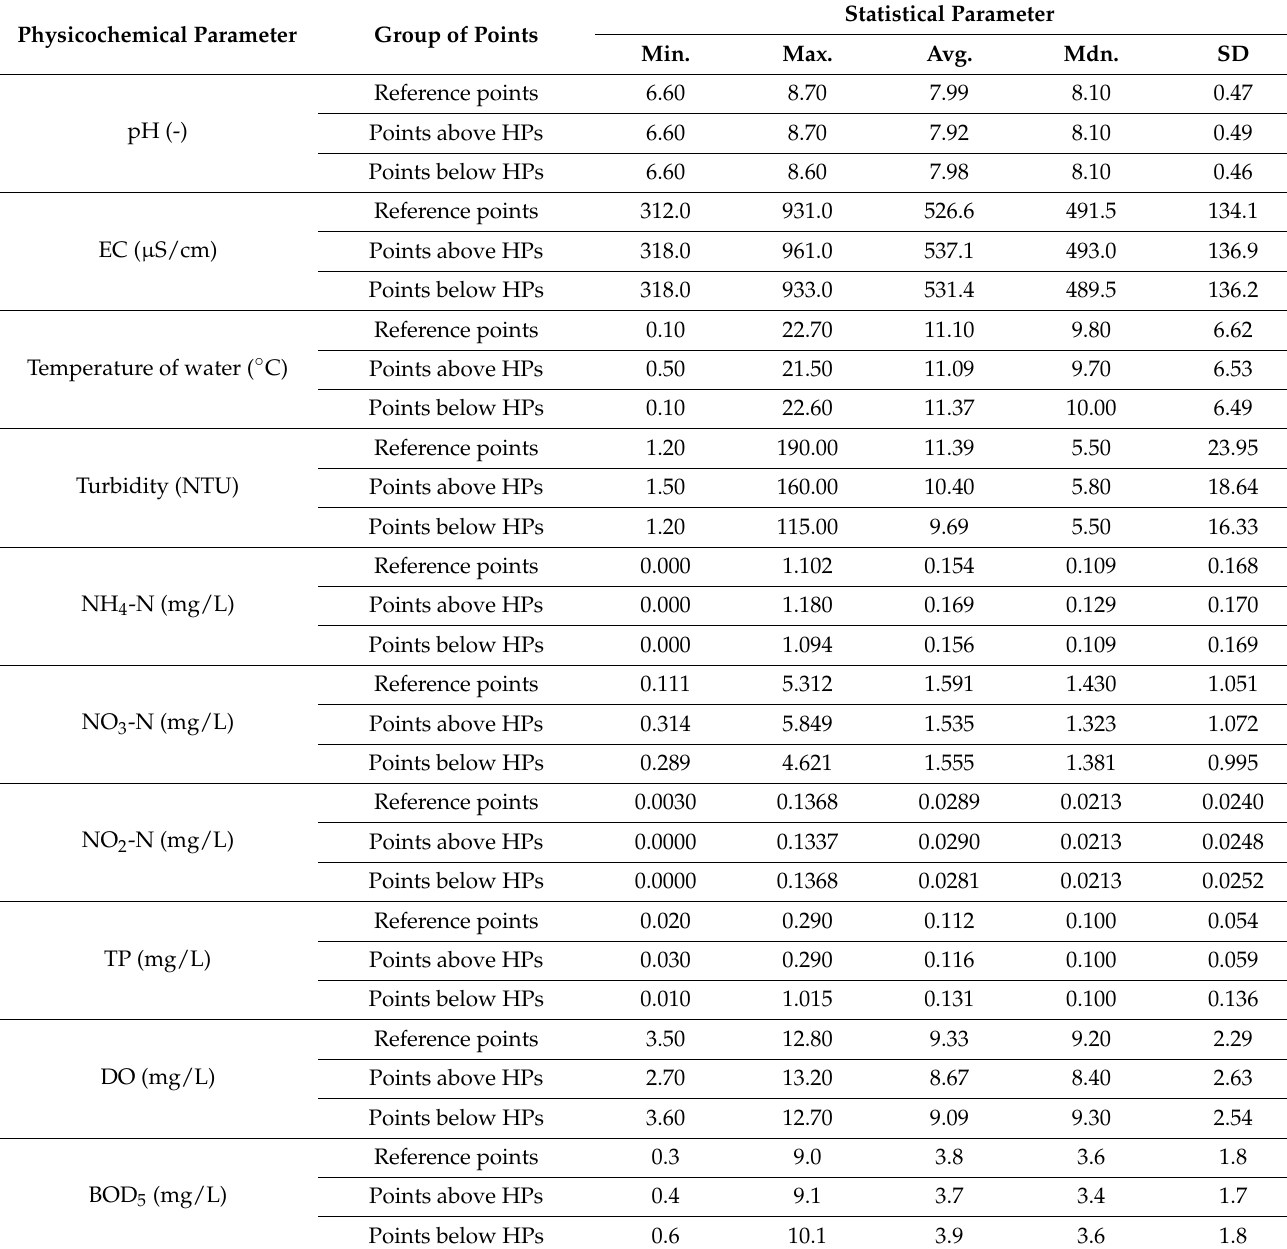
Table 4. Basic statistics for tested physicochemical parameters at reference points, points above HPs and below HPs (this